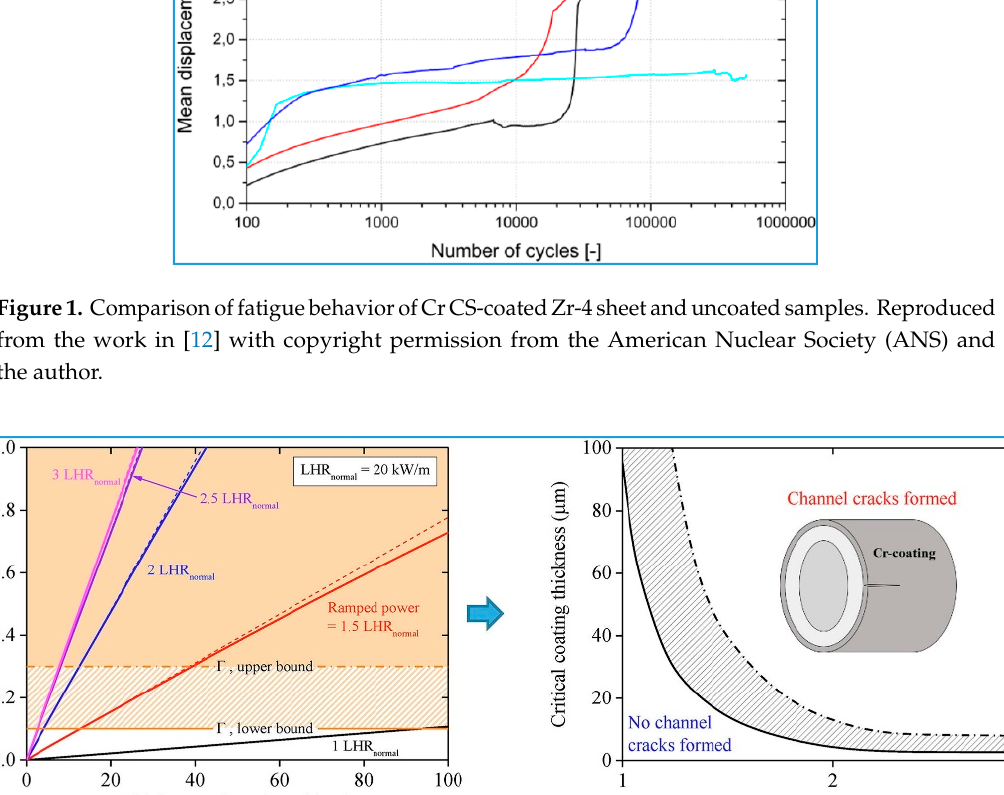
Figure 2. Functional relationship between critical coating thickness and ramped power. Reproduced from the work in [13] with copyright permission from Elsevier.